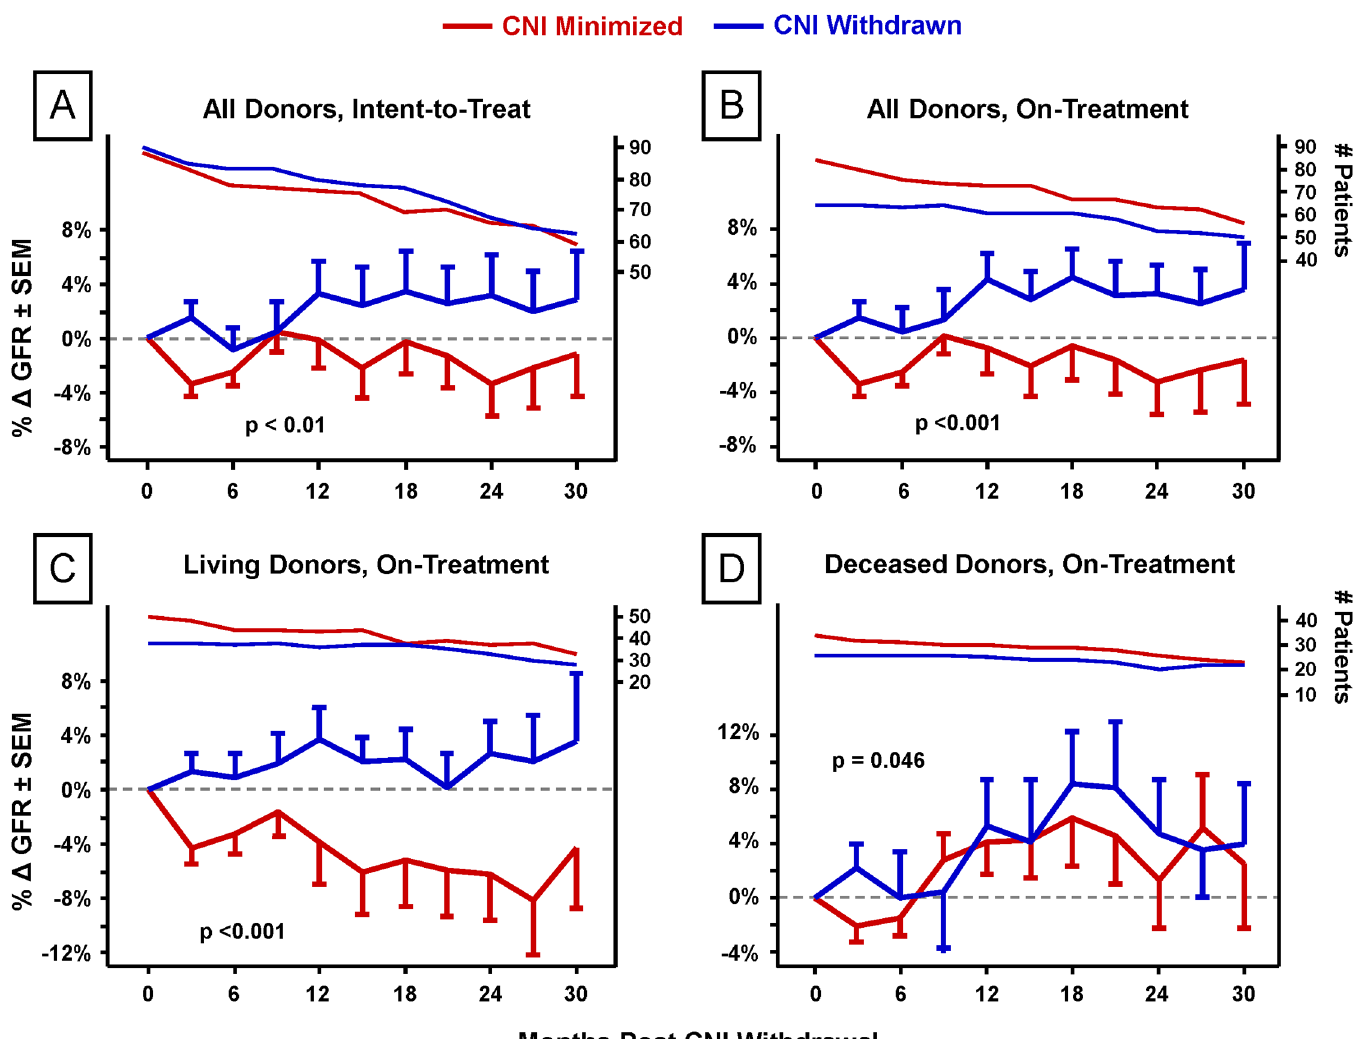
Fig 3. Effect of CNI withdrawal on renal function. The impact of CNI withdrawal on GFR was detected both by intent-to-treat (for all donors, p < 0.01) and on-treatment analyses of deviation from a pre-withdrawal baseline GFR for each patient. Post-transplantation months 3 – 6 GFR values were averaged for use as baselines for CNI-minimization patients; for CNI-withdrawn patients, the three months preceding actual withdrawal were used. To ensure a valid on- treatment comparison of the effects of CNI withdrawal, five patients in the CNI-minimization arm were censored from the analysis due to early rejection ( < 6 months) because such patients were disqualified from withdrawal in the CNI-withdrawn group. Each time point is the average percentage change of three months of GFR